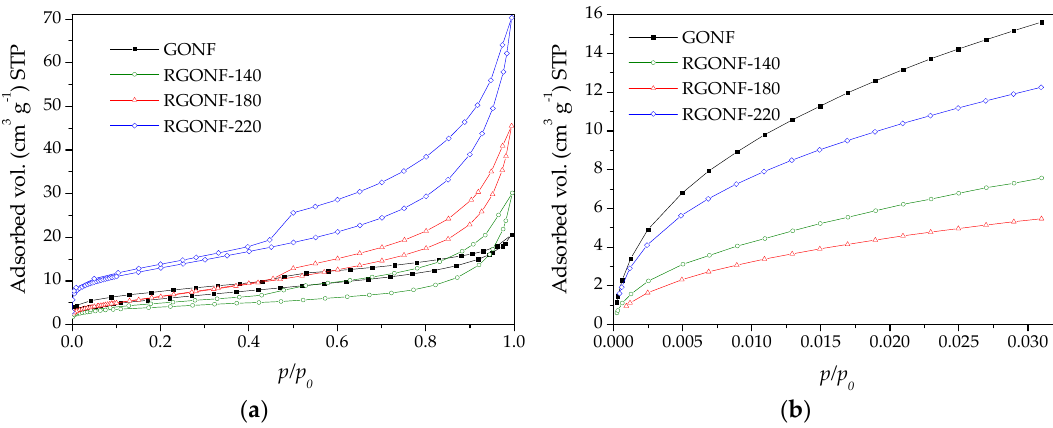
Figure 4. ( a ) Isotherms of N 2 at 77 K and ( b ) CO 2 at 273 K for GONF and RGONFs. Table 3. Textural parameters of GONF and RGONFs obtained at 140, 180, and 220 °C.